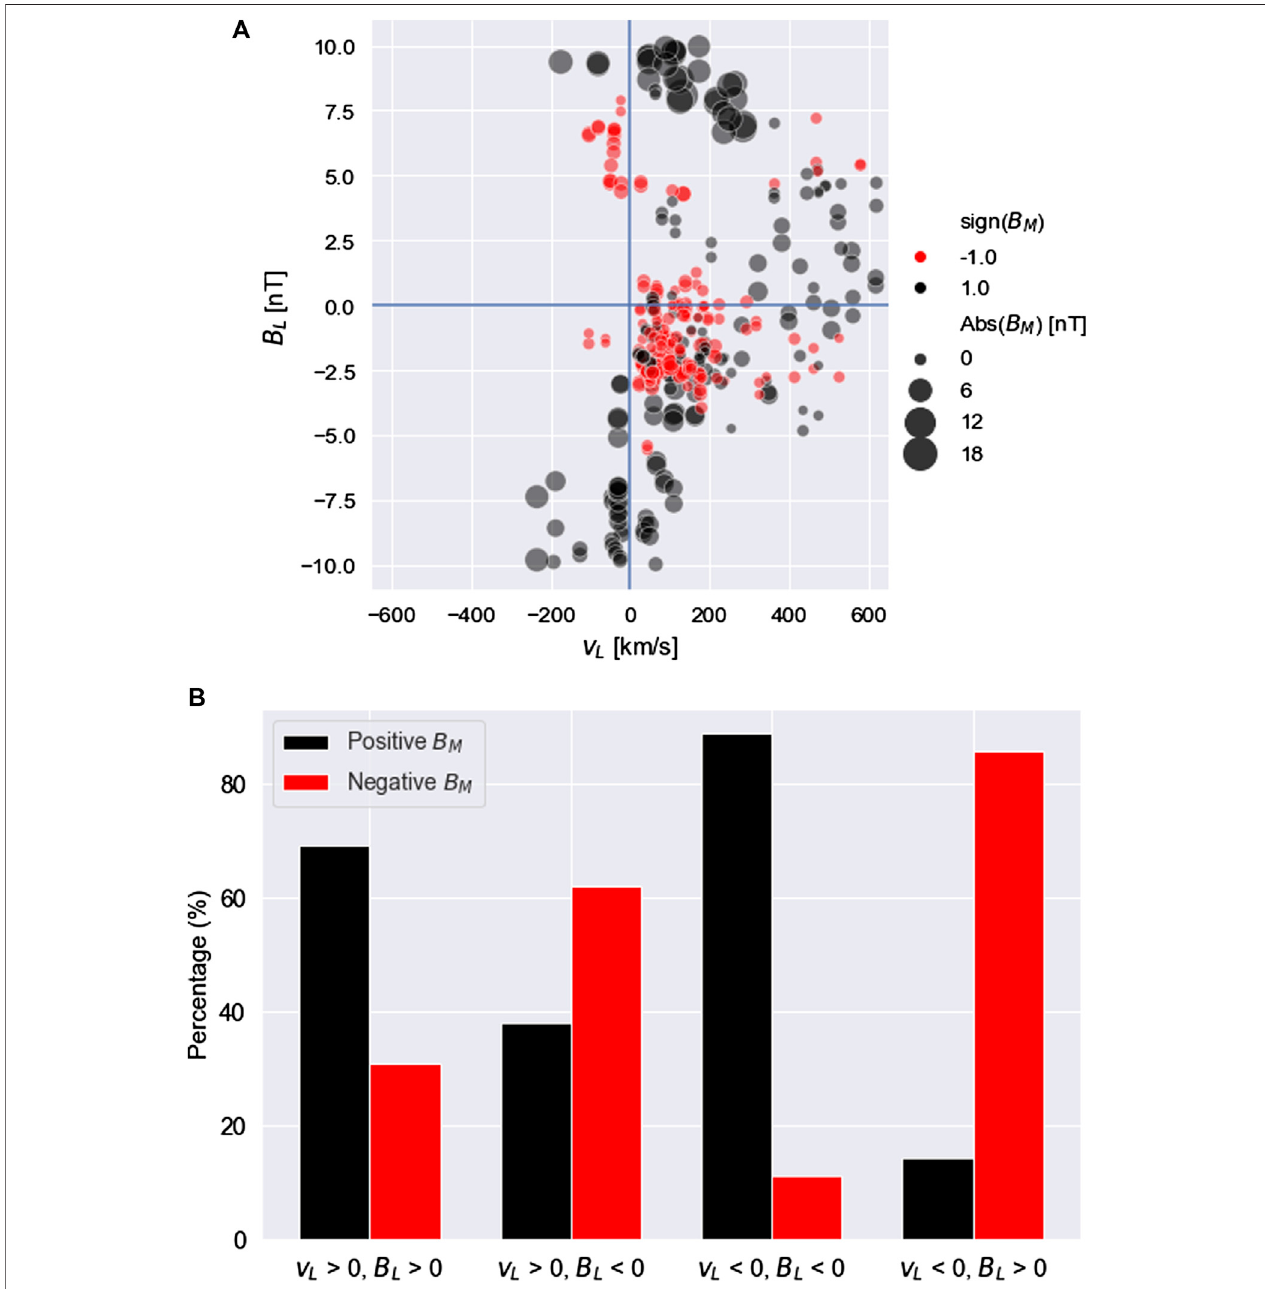
FIGURE5|(A) Statisticaldeterminationofareconnectionsite.Quadrupoleplotshowing B M asafunctionof B L and v L ,acrossa10 minwindowcenteredonthe B N reversalin Figure3 (at23:36:52UT)afterthetearinginstabilitydistributions.Blackdotscorrespondto B M > 0andreddotscorrespondto B M < 0.Thesizeofthedotsis proportional to the magnitude of B M . (B) The percentage of instances with B M > 0 and B M < 0 in each